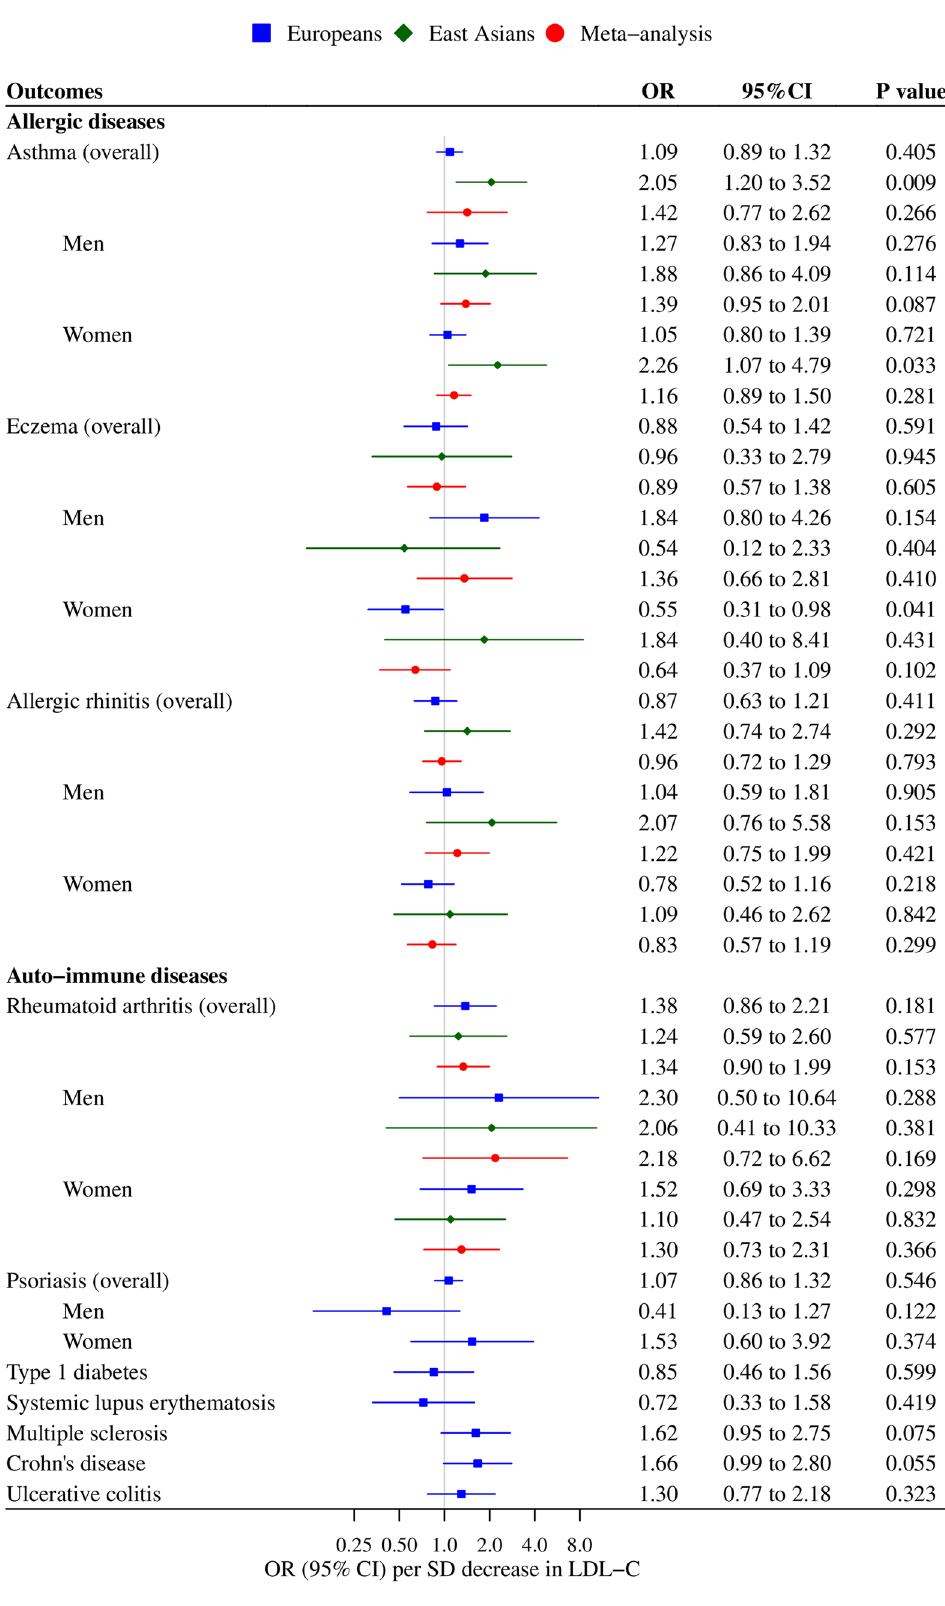
Figure 1. Genetically mimicked effects of statins via HMGCR inhibition (based on rs12916) on allergic and auto-immune diseases. HMGCR 3-hydroxy-3-methylglutaryl-coenzyme A reductase, OR odds ratio, CI confidence interval, SD standard deviation, LDL-C low-density lipoprotein cholesterol. Only rs12916 was included in the analysis using inverse variance weighted (IVW) method. The unit of LDL-C reduction is approximately 0.87 mmol/L in Europeans and 1.06 mmol/L in East